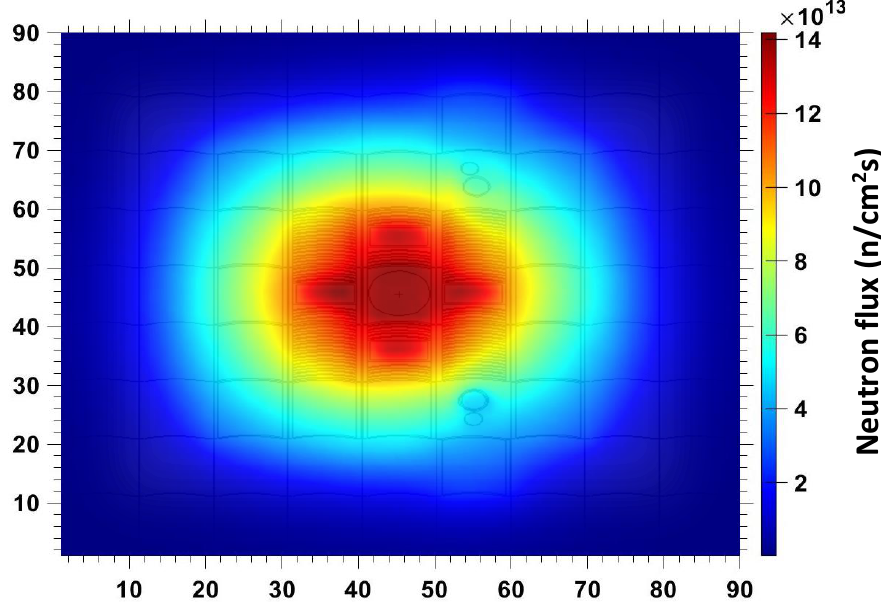
Figure 9. Neutron flux profile for the proposed MSTR-HPC core obtained by the MCNP simulation. Table 4. Neutron Flux Spectrum In-Core Irradiation Facilities for MSTR-HPC.